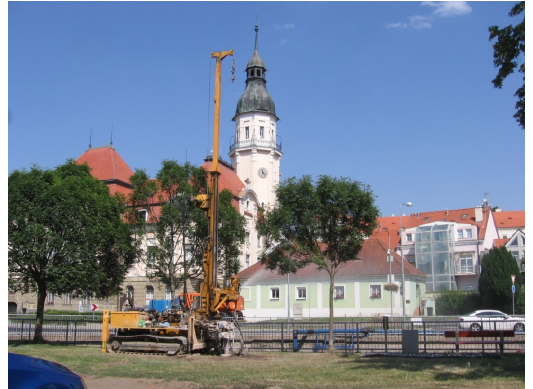
Figure 3. Groundwater monitoring well realisation, to the left in the background the historical building of Bílina city